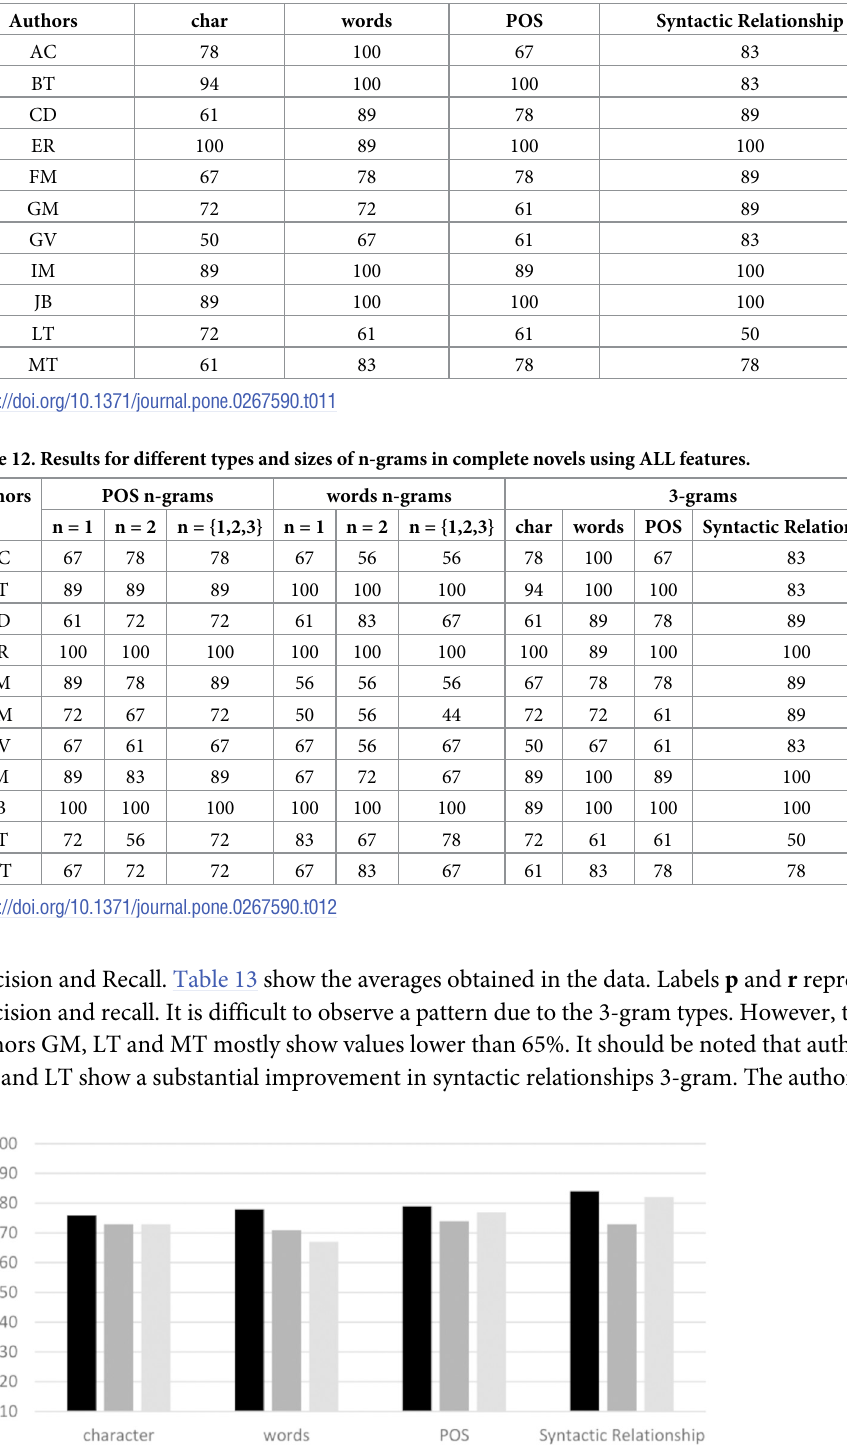
Fig 10. Accuracy (%) averages in models with and without a dimension reduction.